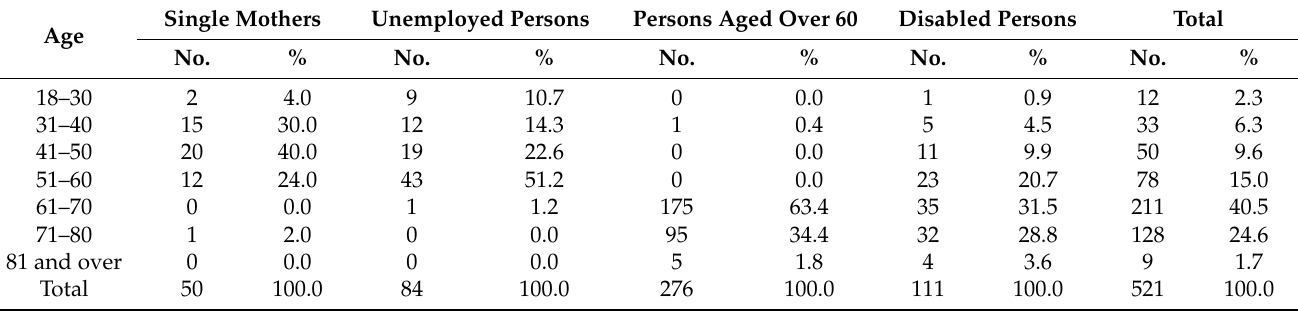
Table 2. Characteristics of the survey population by age and social status ( n =